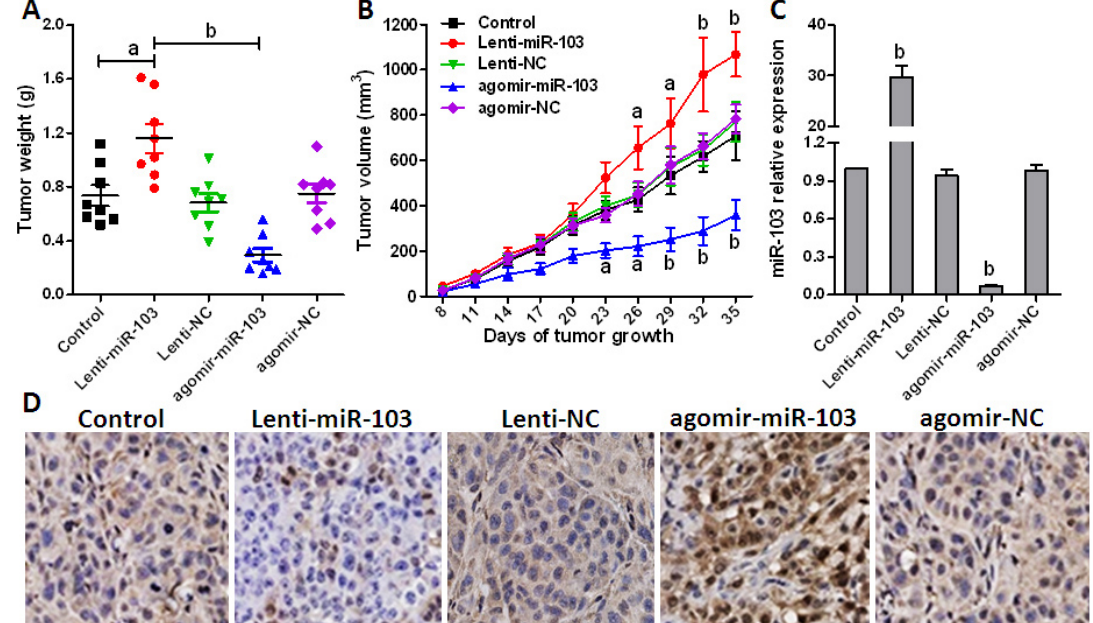
Figure 6. miR-103 promotes colorectal cancer xenograft growth. ( A ) Xenograft models ( n = 8) in nude mice were generated with transfected HCT-116 cells as indicated. Tumor size was measured every three days for 5 weeks; ( B ) Xenograft tumors in nude mice were weighed; ( C ) Relative miR-103 expression in xenografts was analyzed by real-time PCR; and ( D ) PTEN in tumor tissues from various groups was detected with immunohistochemistry using specific PTEN antibodies (200× magnification). Error bars represent as mean ± SD. a p < 0.05; b p < 0.01 vs.